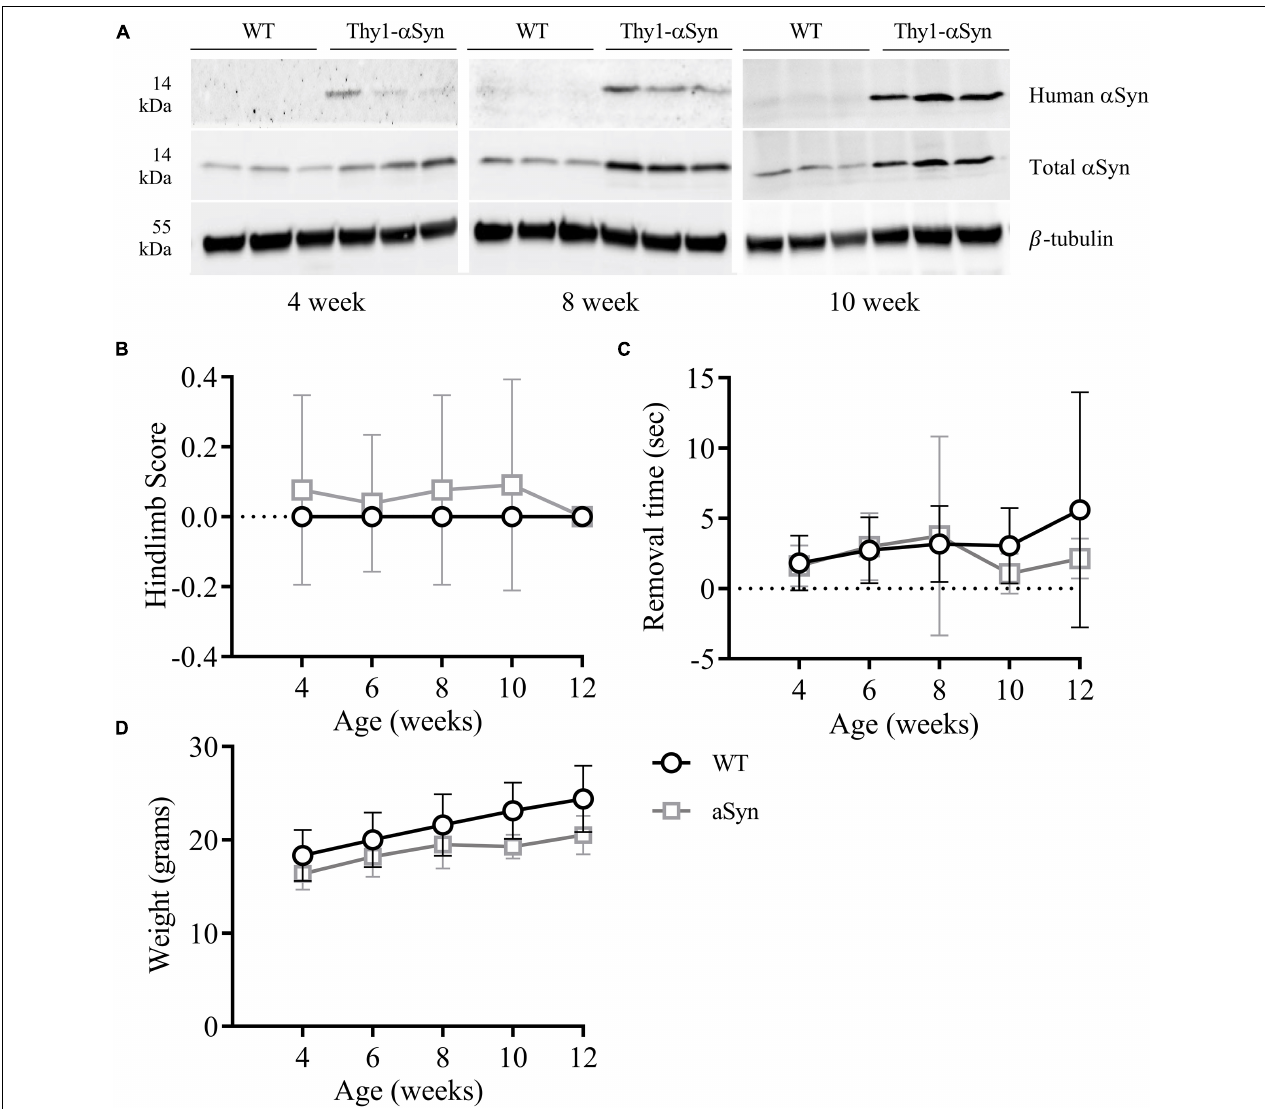
FIGURE 2 | Progessively increasing brain α Syn levels are not associated with notable motor impairments in 12-week old mice. Compared to WT mice, the Thy1- α Syn mice exhibit progressively increasing human and total α Syn in whole brain lysates compared to WT mice at 4, 8 and 12 weeks of age (A) . There were no significant differences in hind-limb clasp scores (B) or nasal adhesive removal (C) between animal groups. The weight of both groups increased with age, where the Thy1- α Syn mice consistently weighed less (D)